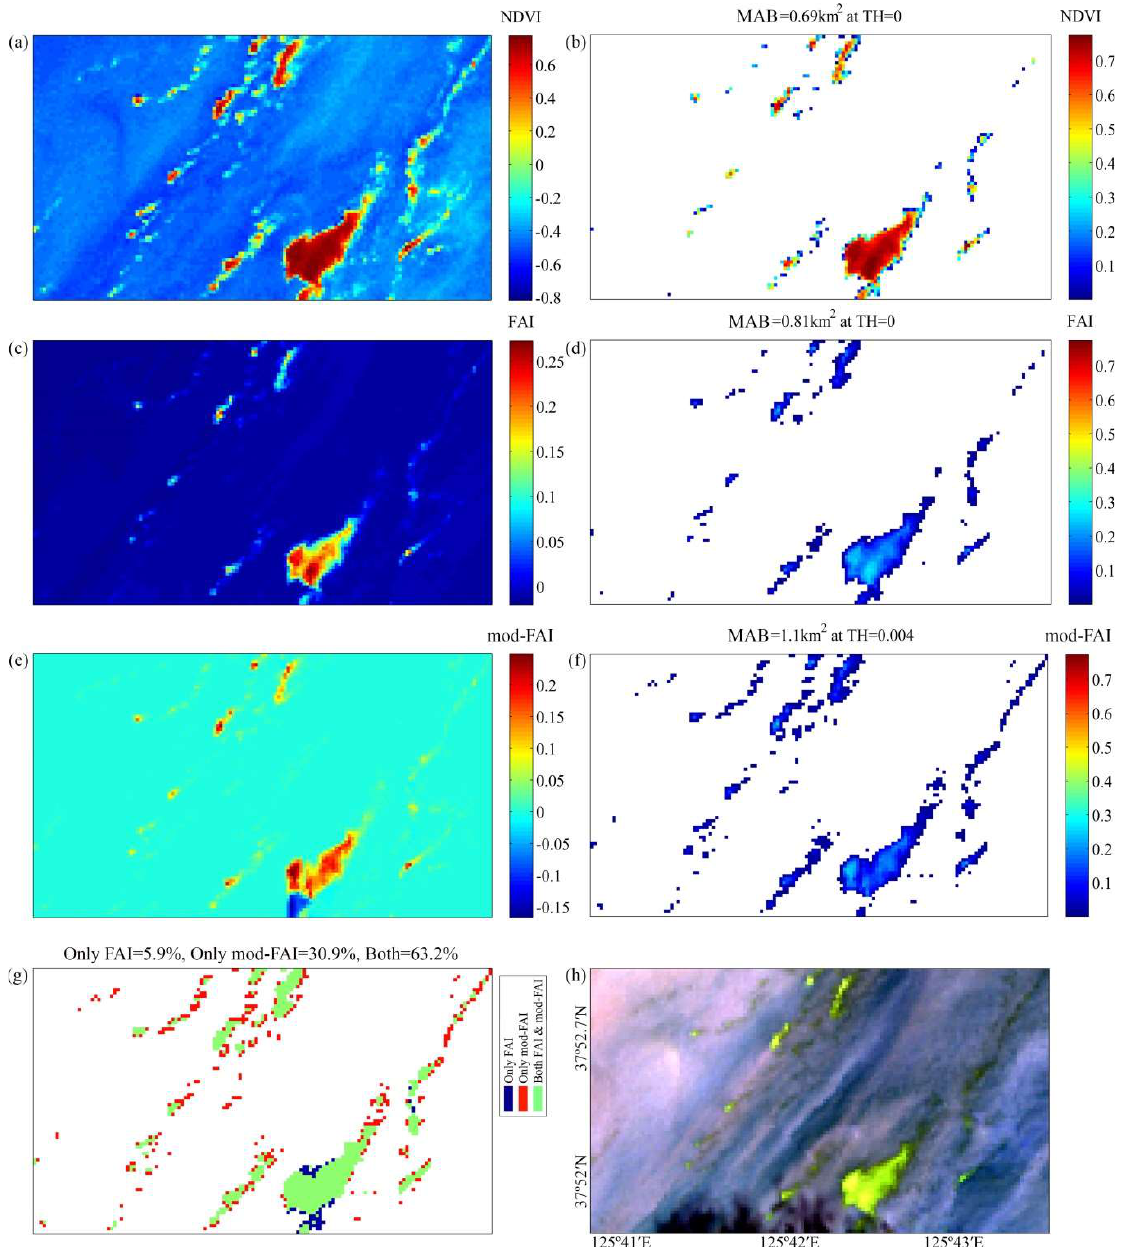
Figure 6. Comparison of Landsat-8 based vegetation indices colourmaps of ( a ) NDVI, ( c ) FAI, and ( e ) modified FAI with the thresholding-based detected macroalgae in the corresponding vegetation indices ( b , d , and f , respectively) for the small ROI area (Figure 1) of path/row 116/34 on 2 August 2014 at 02:11 UTC. The respective ( g ) common as well as only FAI and modified FAI-based detection, and ( h ) the natural colour composite image (Landsat bands 4, 3, and 2) are also compared. The modification of FAI showed better detection of the small patches of macroalgae and are thus applied to the images covering the study areas. The results of detection for some images covering the study areas are shown in Figures 9–11 after grouping into respective